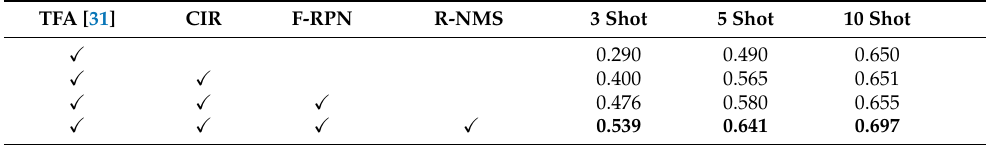
Table 6. Ablation experiment on the NWPU VHR-10 Dataset.